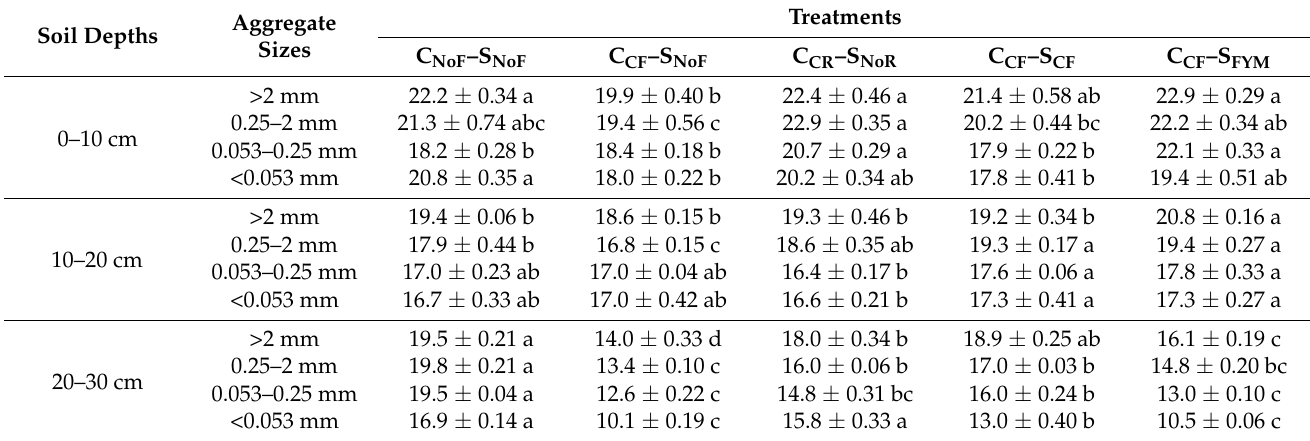
Table 4. SOC content (g kg − 1 ) within soil